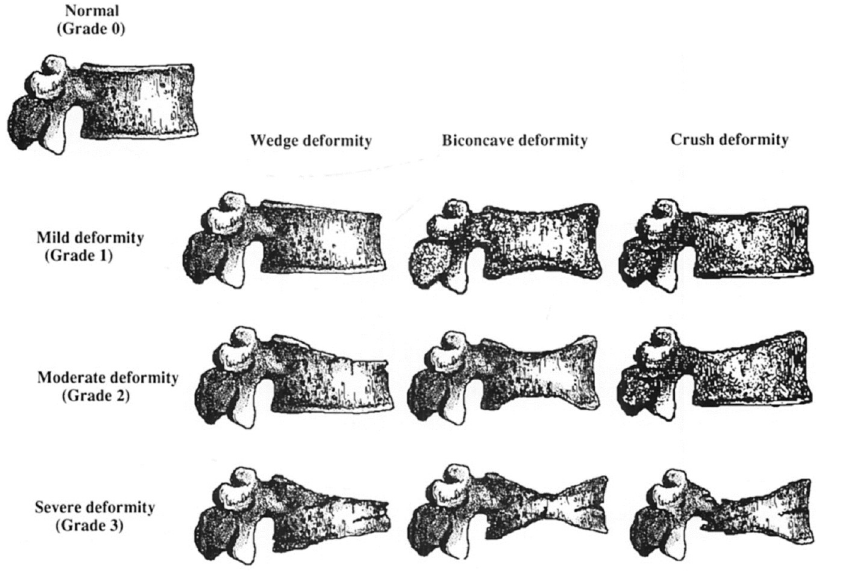
Fig 1. Semiquantitative visual grading of vertebral deformities (from reference